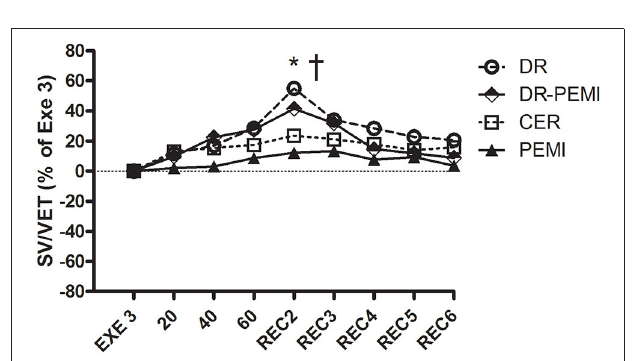
FIGURE 7 | SVR time courses during all four tests. Values are means ± SD percentages of the end of handgrip (EXE3). * = P < 0.05 vs. EXE3. † = P < 0.05 vs. PEMI.